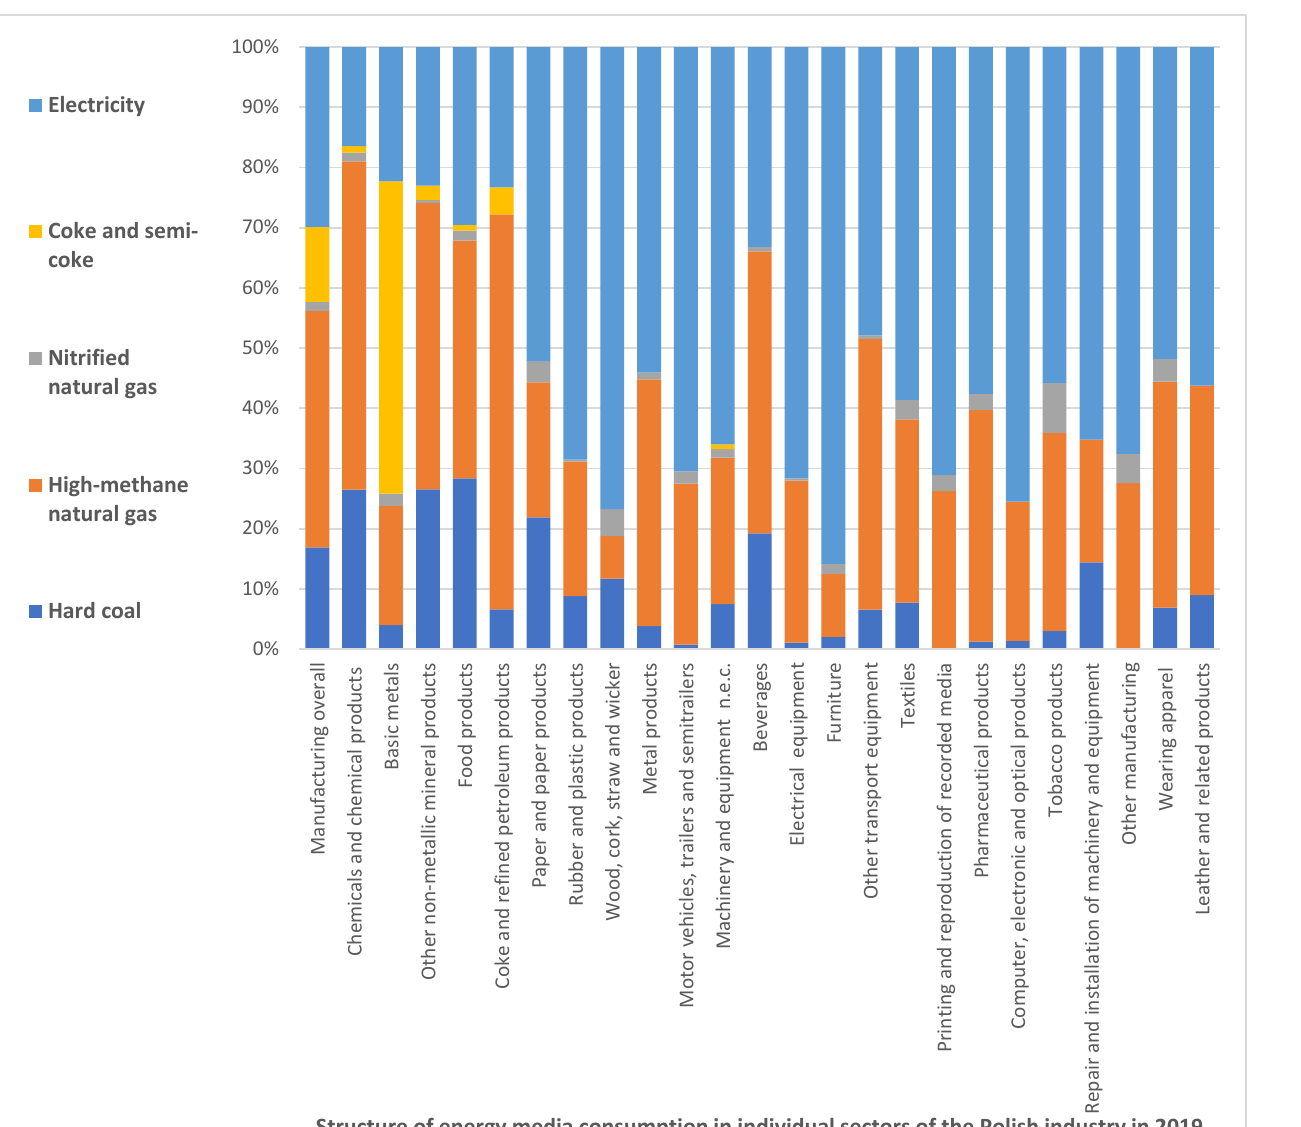
Figure 4. The structure of energy media consumption in individual sectors of the Polish industry in 2019 (own study based on Statistics Poland report [37]).